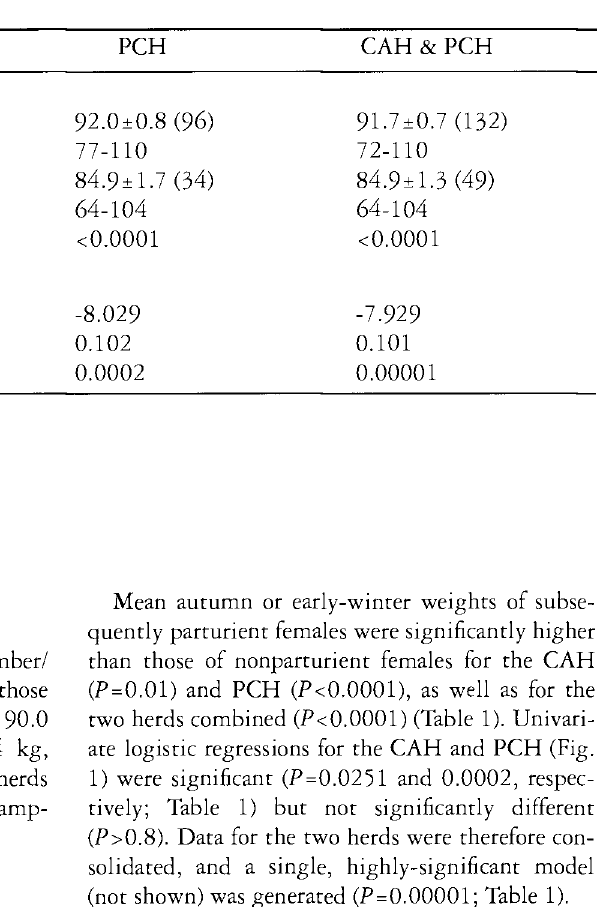
Table 1. Body weights 1 ± standard error of the mean, and parturition models for female caribou 1, of the Central Arctic herd (CAH) and Porcupine herd (PCH).